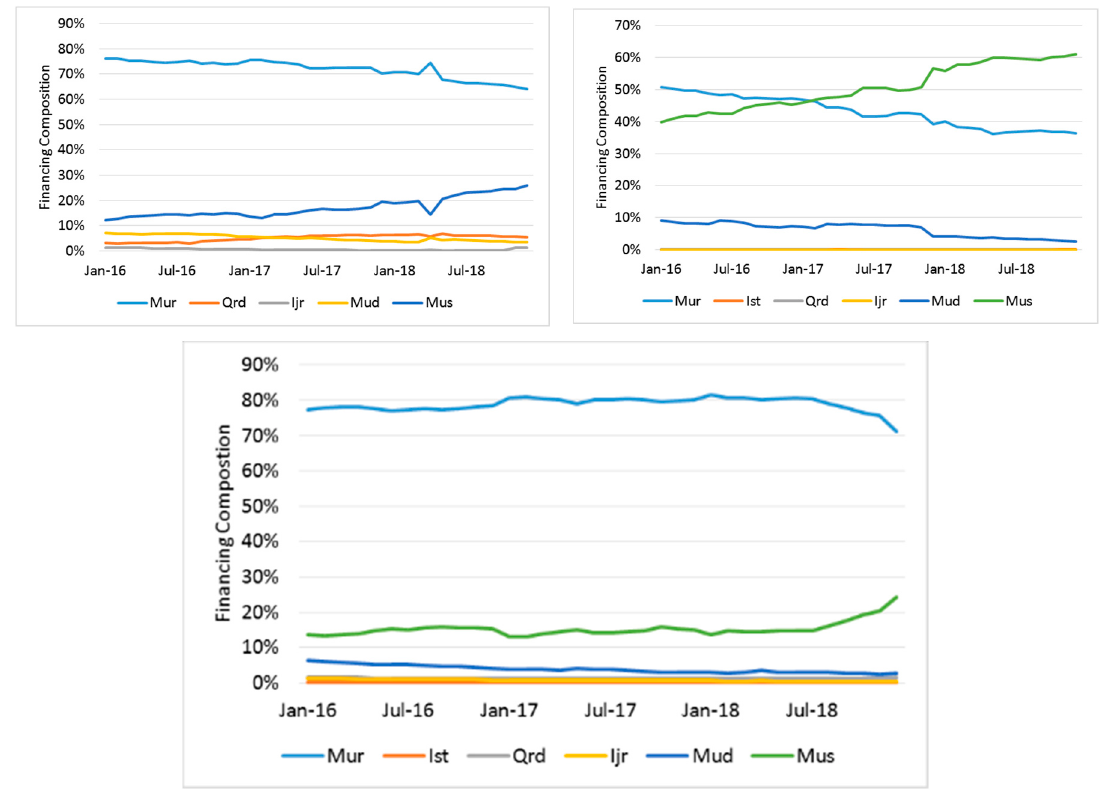
Figure 3. Compositions of financing fund from Bank A ( top left ), B ( top right ) and C ( bottom ).